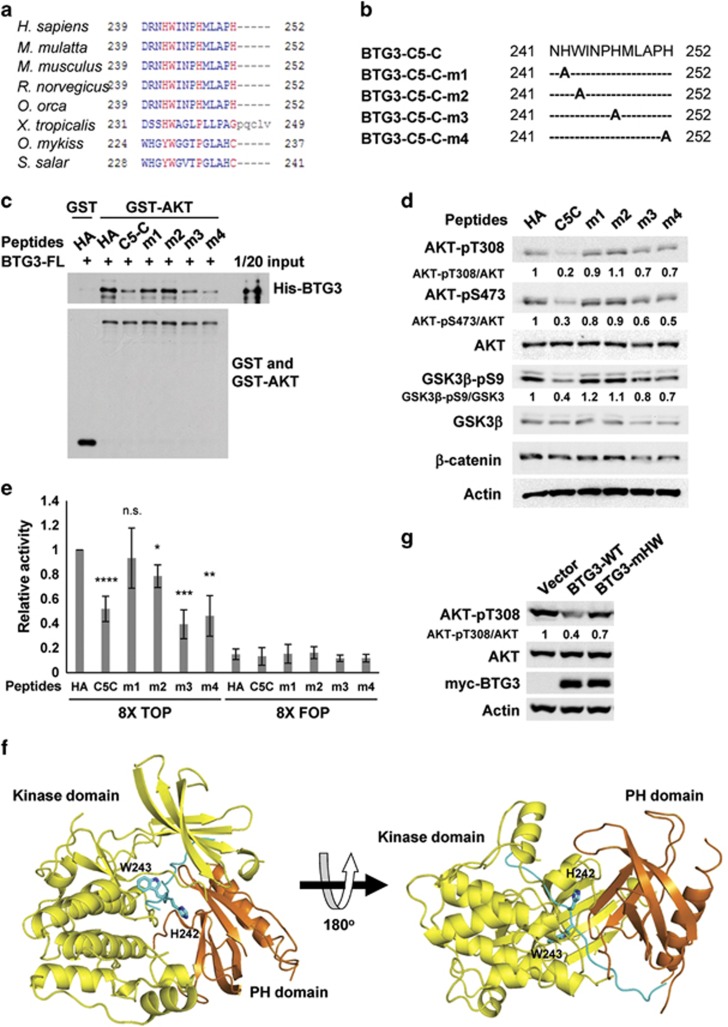
Identification of BTG3 C-terminal residues critical for AKT suppression. (a) Alignment of the C termini of BTG3 from different species. Residues with high conservation are shown in red. (b) Schematic representation showing the Ala substitution in the C5-C mutants. (c and d) An Ala substitution at position H242 or W243 attenuates the inhibitory activity of the C5-C peptide in an in vitro interaction assay (c) and on AKT-GSK3β signaling in 293 T cells (d). (e) Inhibition of the β-catenin/TCF reporter activity by C5-C was abrogated by Ala substitution at H242 and to a lesser extent at W243. *P<0.05, **P<0.01, ***P<0.001, and ****P<0.0001, respectively, by Student's t-test. (f) Docking model of the BTG3 C-terminal peptide (residues M236–H252) in the interdomain region of AKT1. The peptide (blue) sits in the interdomain pocket between the PH domain (orange) and the kinase domain (yellow), locking the two domains in a ‘PH-in' conformation. (g) Simultaneous mutation of H242 and W243 to Ala in the context of the full-length protein attenuates the inhibitory activity of BTG3 on AKT in 293 T cells